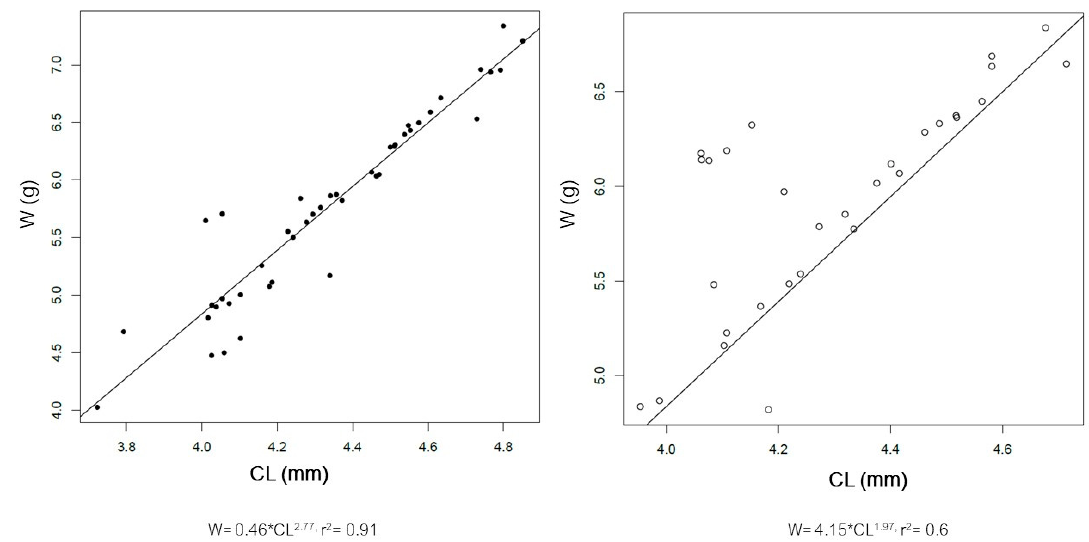
Figure 4. Relationship between carapace length (CL) and weight (W) of the male ( left ) and female ( right ) spiny lobsters Panilurus elephas from the Thermaikos Gulf. The linear regression was performed and plotted with R. Data presented after log-transformation.